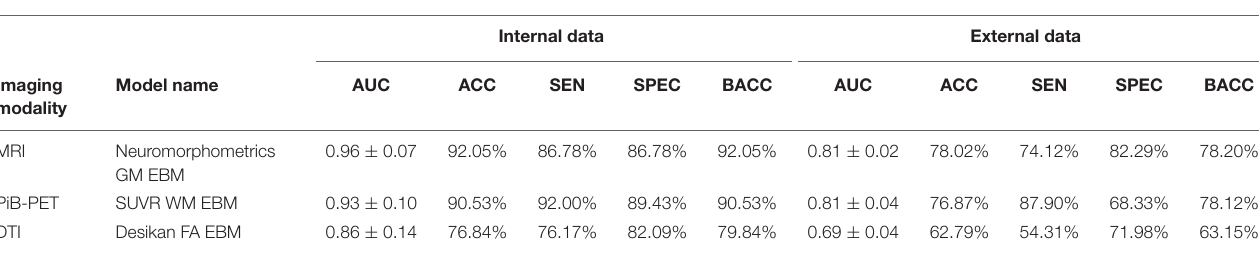
TABLE 6 | Best performing models validated on both the internal and external